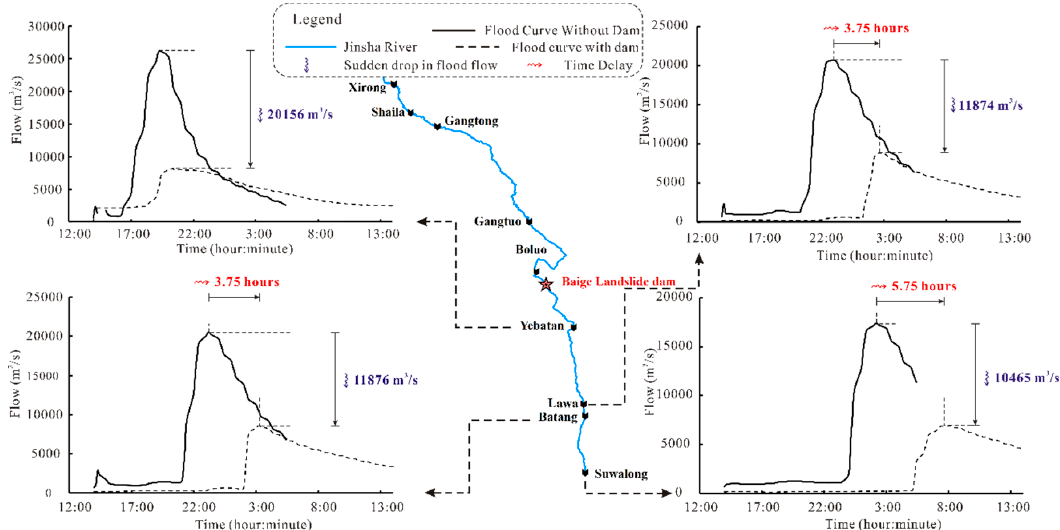
Figure 13. Comparison of outburst flood process curves between natural discharge and high dam interception .